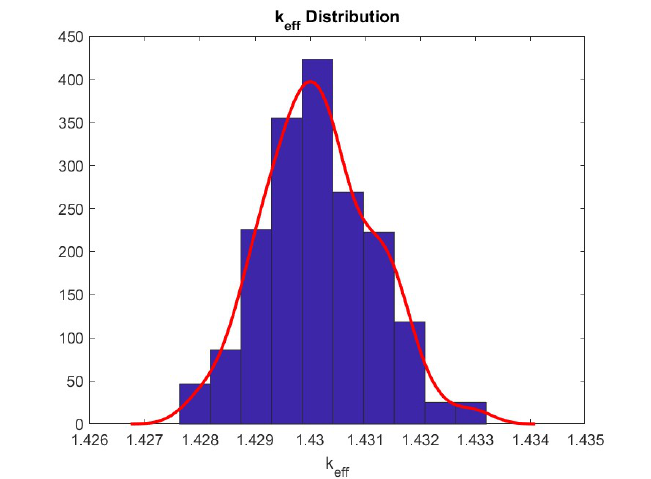
Figure 4. Multiplication Factor Distribution Varying Material